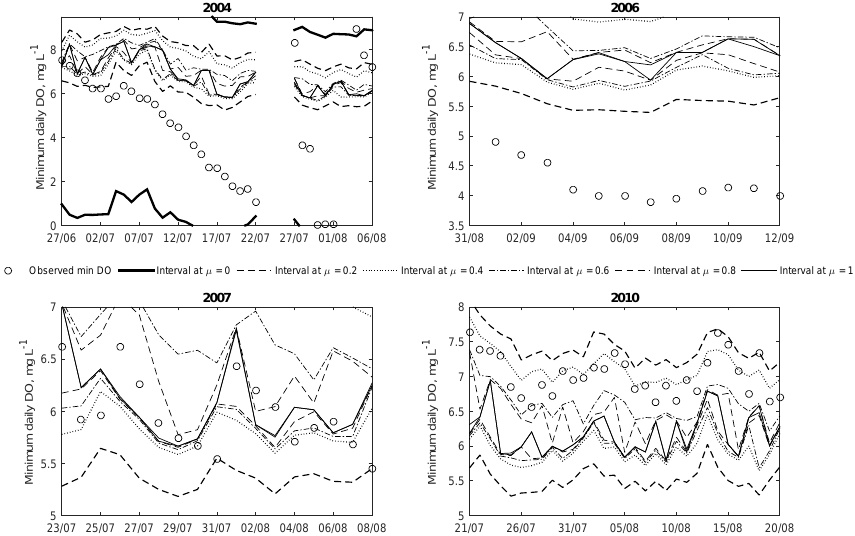
Figure 9. Zoomed-in views of the trend plots for 4 sample years corresponding to important periods with low DO occurrences.